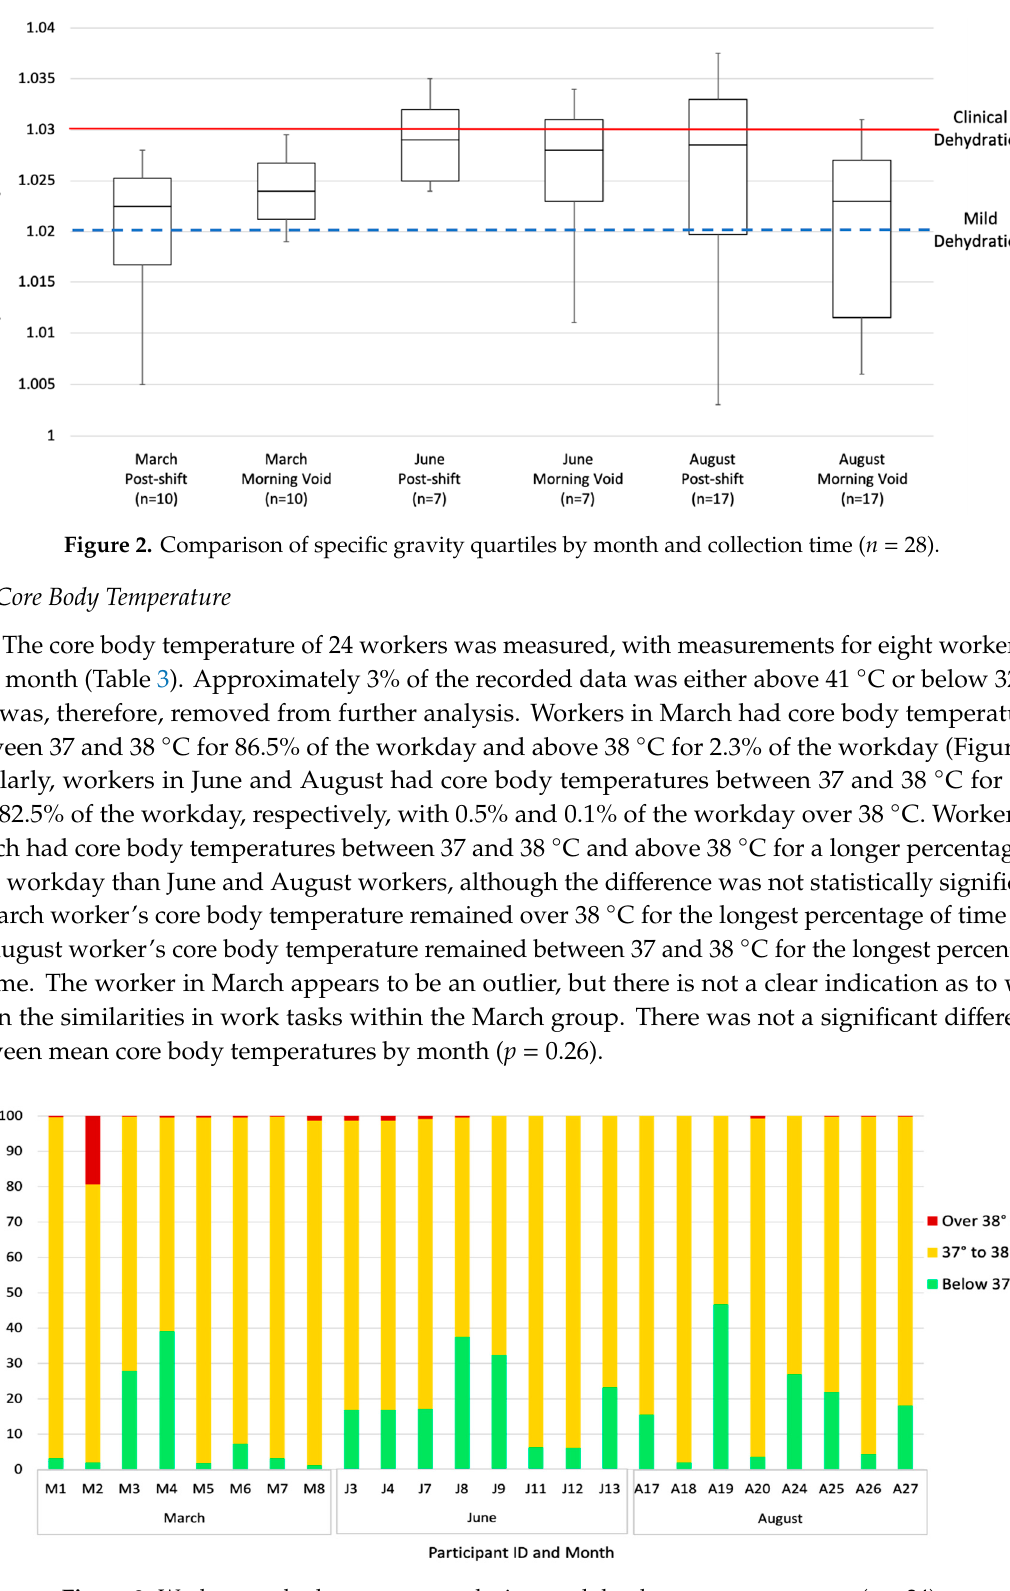
Figure 3. Worker core body temperature during workday, by temperature range ( n = 24).